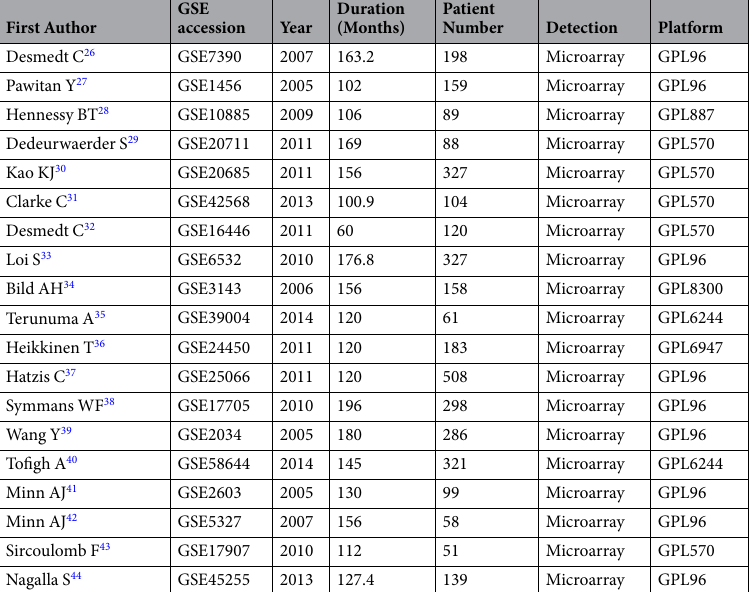
The opposite roles of DACH1 and CD44 in clinical outcomes of breast cancer patients. In order to assess the prognostic value of DACH1 and CD44 in breast cancer, a meta-analysis enrolling a total of 19 published Gene Expression Omnibus (GEO) databases and including 3574 breast cancer patients was per- formed 26–44 . The characteristics of these 19 GSE databases were displayed in Table 1. The results indicated that patients with higher mRNA expression of DACH1 tended to enjoy longer time to death (HR: 0.72 (0.57–0.92), I 2 = 22.9%, P = 0.232) (Fig. 7a), relapse (HR: 0.73 (0.56–0.97), I 2 = 64.1%, P = 0.003) (Fig. 7c) and metastasis (HR: 0.73 (0.56–0.95), I 2 = 27.2%, P = 0.202) (Fig. 7e). On the contrary, higher mRNA expression of CD44 was